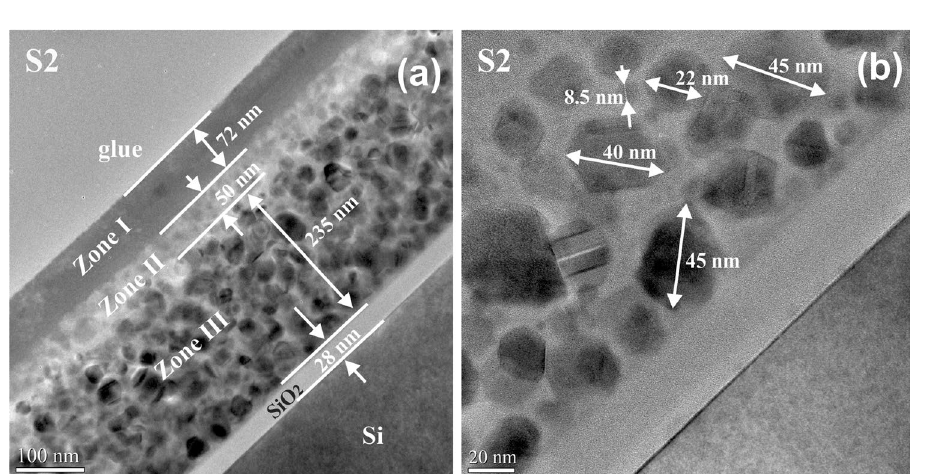
Figure 3. Morphology of S2 film 800 °C RTA for 10 min: ( a ) low magnification XTEM image showing three zones with different morphology; ( b ) HRTEM image of zone III at the interface with the substrate, showing the SiGe NCs embedded in the SiO 2 matrix. The big SiGe NCs (over 30 nm) are facetted and contain nanotwins and stacking faults